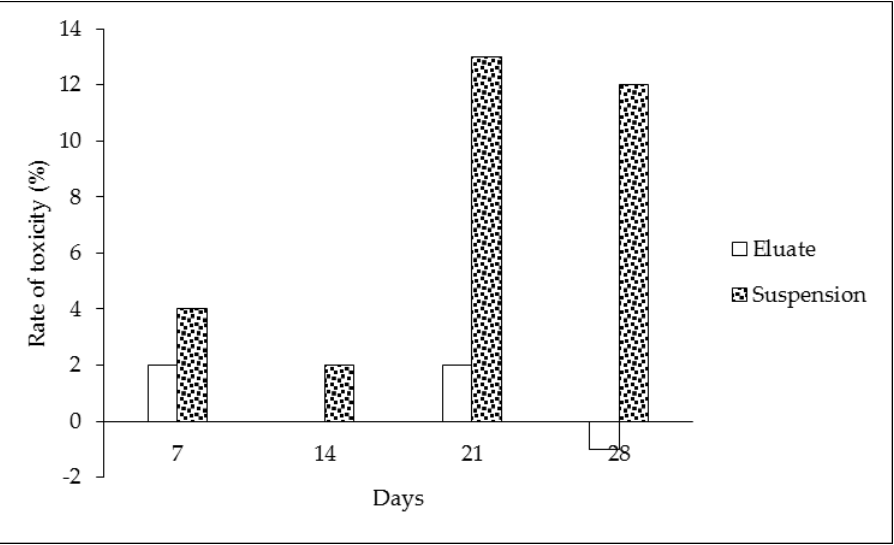
Figure 3. Toxicity of the samples in comparison to the controls during 28 days of the experiment— day 0, 7, 14, 21 and 28 (the data were calculated according to Formula (2)).